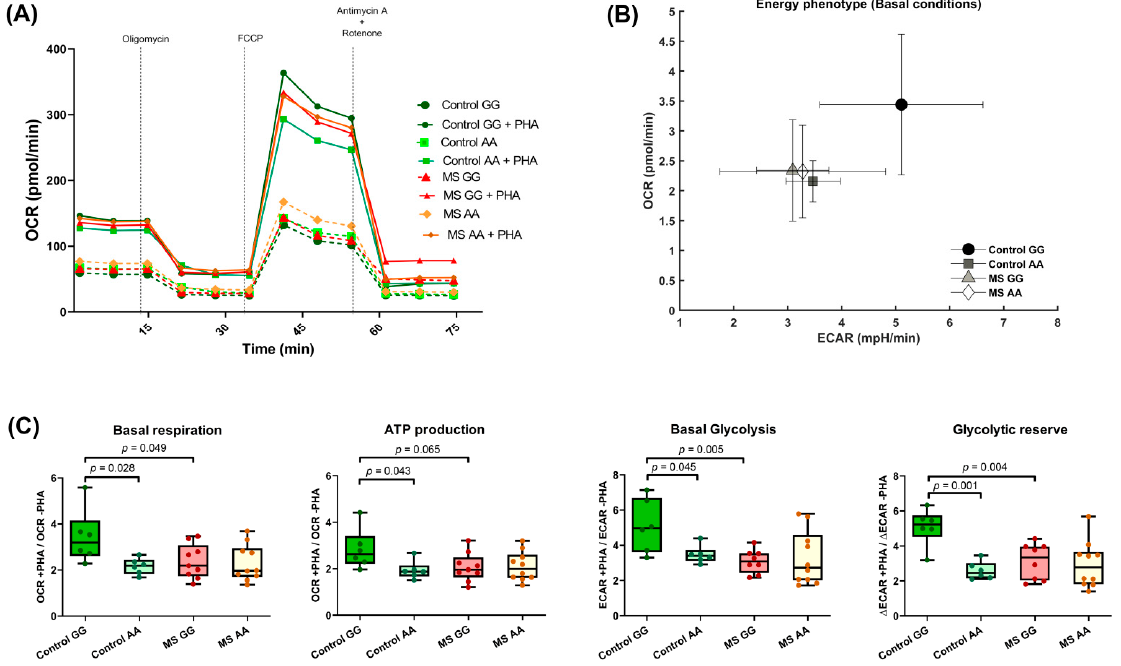
Figure 4. Influence of rs7665090 genotypes on PBMCs metabolism. ( A ) Oxygen consumption rate (OCR) profile of PBMCs from controls and MS patients with/without PHA stimulation stratified by rs7665090 genotype. ( B ) Effect of rs7665090 genotypes on metabolic changes induced by PHA stim- ulation of PBMCs. An increment of basal respiration induced by PHA over an increment of basal glycolysis (Extracellular acidification rate, ECAR) is shown. ( C ) Effect of rs7665090 on basal respi- ration, ATP production, basal glycolysis, and glycolytic reserve (controls GG n =6; controls AA n =6; MS GG n =9; MS AA n =10). Basal respiration: percentage of difference between means in control GG vs. Control AA= 37.23±14.53%; control GG vs. MS GG=31.01±14.28%; ATP production: percentage of difference in between means Control GG vs. control AA=31.63±13.67%; Control GG vs. MS GG=27.14±13.42%; Basal glycolysis: percentage of difference between means in Control GG vs. Con- trol AA=32.08±12.74%; Control GG vs. MS GG=39.42±11.65%; Glycolytic reserve: percentage of dif- ference between means in Control GG vs. Control AA=49.06±8.1%; Control GG vs. MS GG=38.61±11.05%. Box and whiskers diagrams: the line represents the median value, the box the 25 and 75 percentiles, and whiskers mark maximum and minimum values. All comparisons were per- formed with Student’s t test. 4. Discussion Translating GWAS signals into functionally relevant results is a challenge. Often, an extensive linkage disequilibrium (LD) surrounding the associated polymorphisms ham- pers the localization of the causal variant(s). Moreover, the assumption of one causal var- iant does not fit reality in many regulatory regions, where multiple tightly linked etiolog- ical SNPs could be underlying expression quantitative trait loci (eQTL) and GWAS loci, as recently reported [33]. The MS-risk SNP rs7665090 is located in the 3 ′ end of the MANBA gene and included in an LD block together with other 95 proxies (R 2 >0.8). Interestingly, all these SNPs are located in MANBA intronic or untranslated regions. A recent study in primary biliary cholangitis [34], another autoimmune disease, confirmed the existence of two different LD blocks in this region: one regulating NF ĸ B and represented by rs17032850, and another including MANBA and represented by rs227361. This latter SNP (in high LD with rs7665090, R 2 =0.81) has been associated with MS risk in a recent GWAS, and both rs227361 and rs7665090 hold the best regulatory scores in the MANBA block